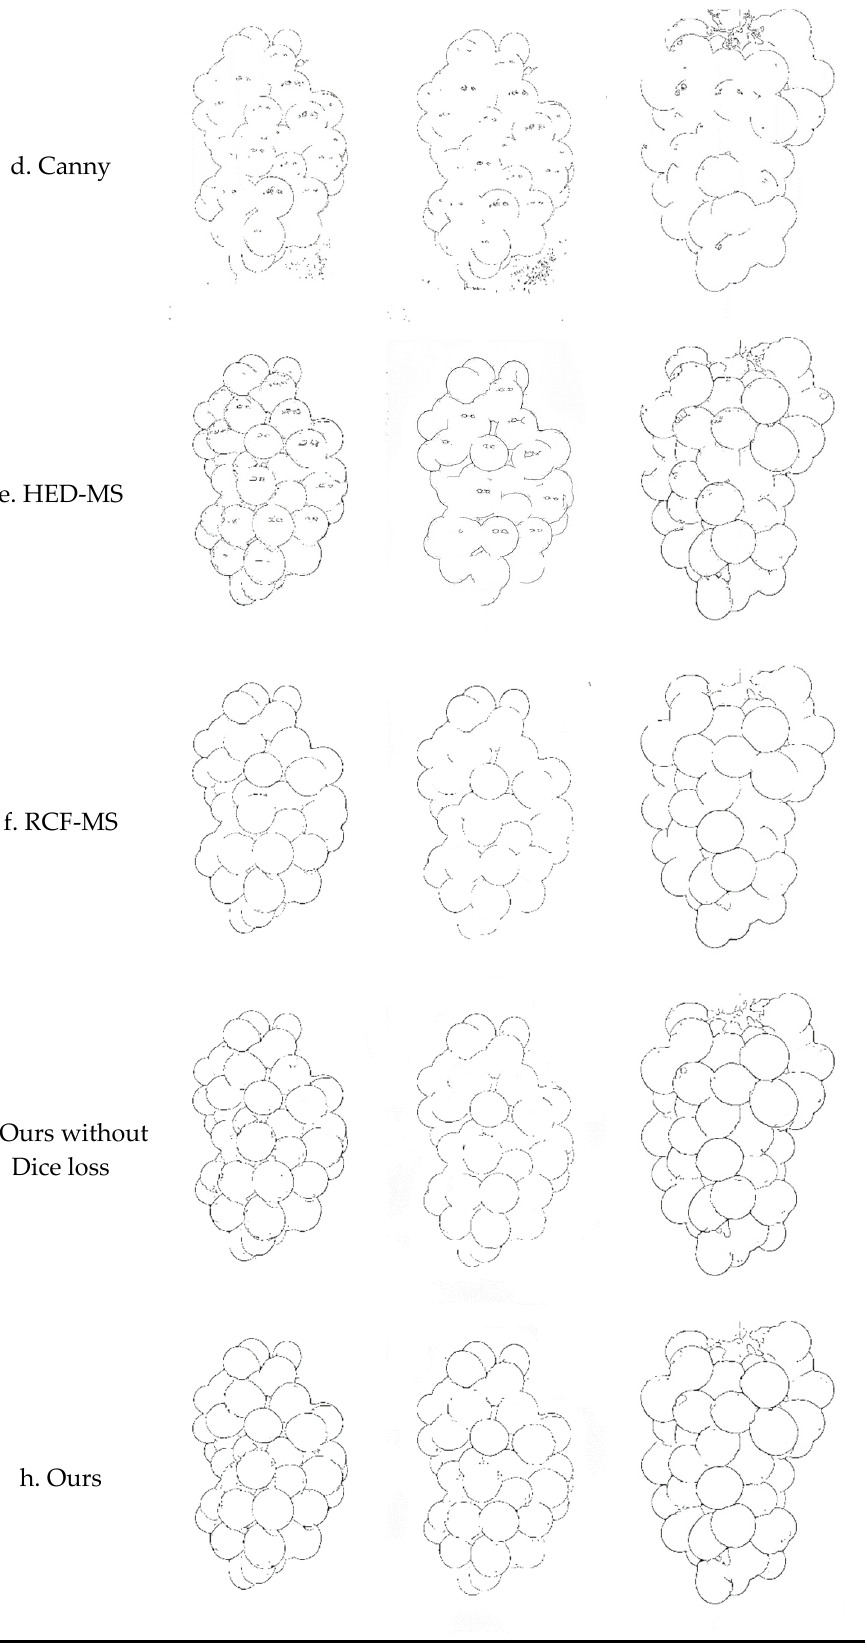
Figure 10. Experimental results of six algorithms for images with different lighting conditions.